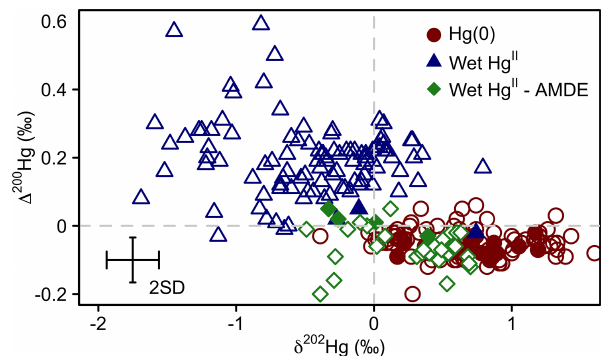
Figure 4. Mass-dependent fractionation ( δ 202 Hg) versus even mass-independent fractionation ( (cid:49) 200 Hg) of atmospheric Hg(0) (red circles), Hg(II) in wet deposition sampled at locations or dur- ing seasons when no AMDEs occurred (blue triangles), and Hg(II) in Arctic show sampled during the springtime AMDE season (green diamonds) for the Arctic tundra at Toolik Field Station (filled sym- bols), and reported from elsewhere (empty symbols). Atmospheric Hg(0) data are from Gratz et al. (2010), Demers et al. (2013, 2015), Fu et al. (2016a), Enrico et al. (2016), and Obrist et al. (2017); Hg(II) in wet deposition are from Demers et al. (2013), Sherman et al. (2015), Chen et al. (2012), and Gratz et al. (2010); and Hg(II) in snow from AMDEs are from Obrist et al. (2017) and Sherman et al. (2010, 2012a). Error bars represent the analytical precision de- termined by the 2SD from multiple measurements of an in-house